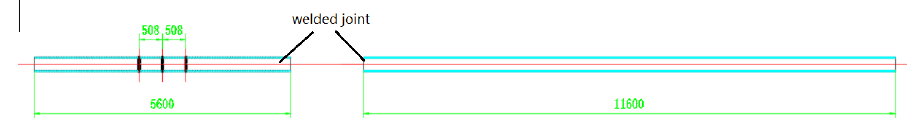
Figure 15. Schematic diagram of the loading test riser specimen.